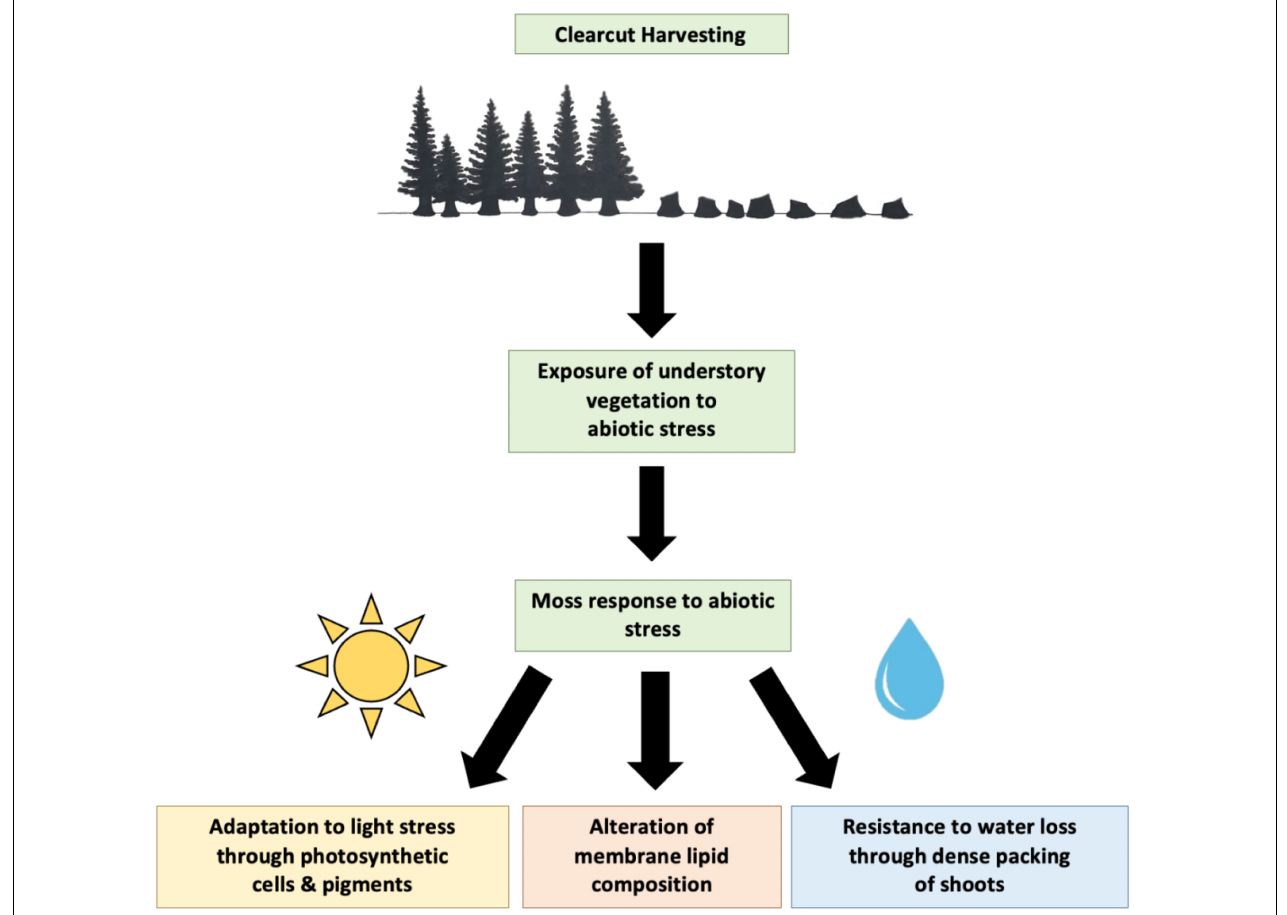
FIGURE 3 | Diagram displaying potential response of moss to abiotic stress during boreal forest regeneration following clearcut harvesting.